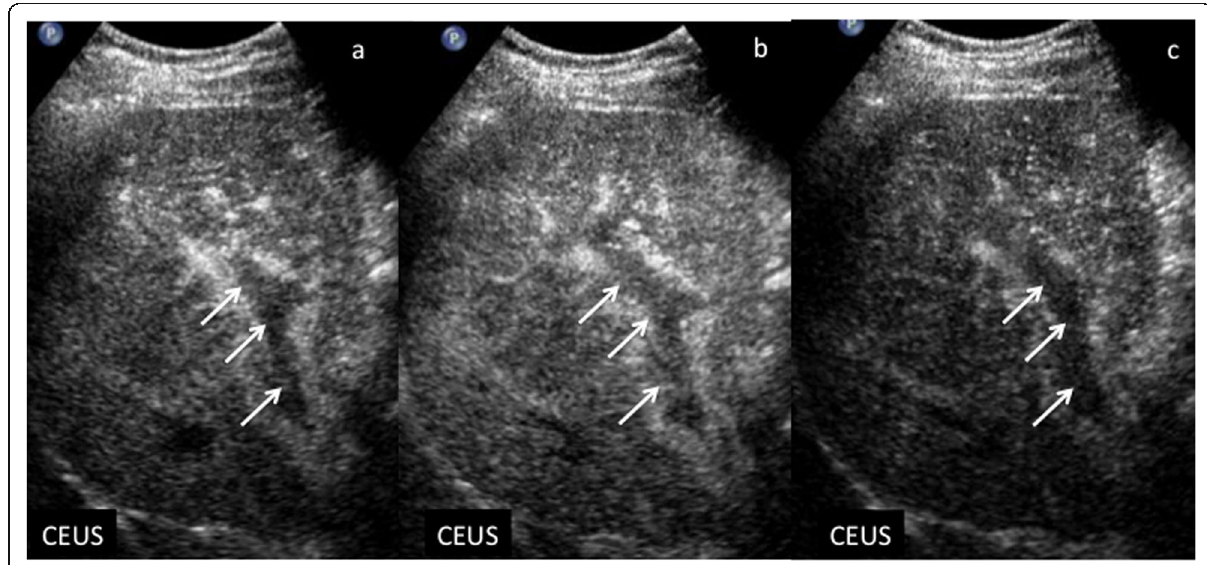
Fig. 13 Non-neoplastic thrombosis in a 62-year-old man with virus B-related cirrhosis. At CEUS, no enhancement is appreciable in the context of the right branch of portal vein during the arterial ( a ), portal venous ( b ), and late ( c ) phases, respectively